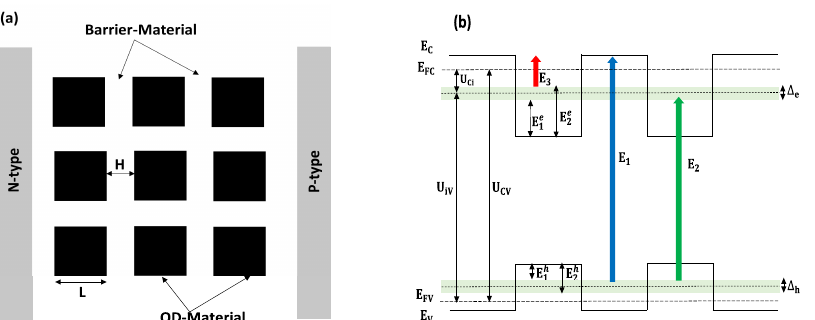
Figure 1. ( a ) Schematic diagram of the QD-IBSC structure. The black cubes represent QD material, which are embedded into the barrier material. ( b ) Energy band diagram of the QD-IBSC where E C and E V denote the energies of CB and VB of the host material and E 1 represents its band gap. E 2 and E 3 are the energies of bottom and top sub-gaps, respectively, and U iv ( U ci ) is the chemical potential between VB and IB (IB and CB). ∆ e and ∆ h are the IB widths of the electron and hole,